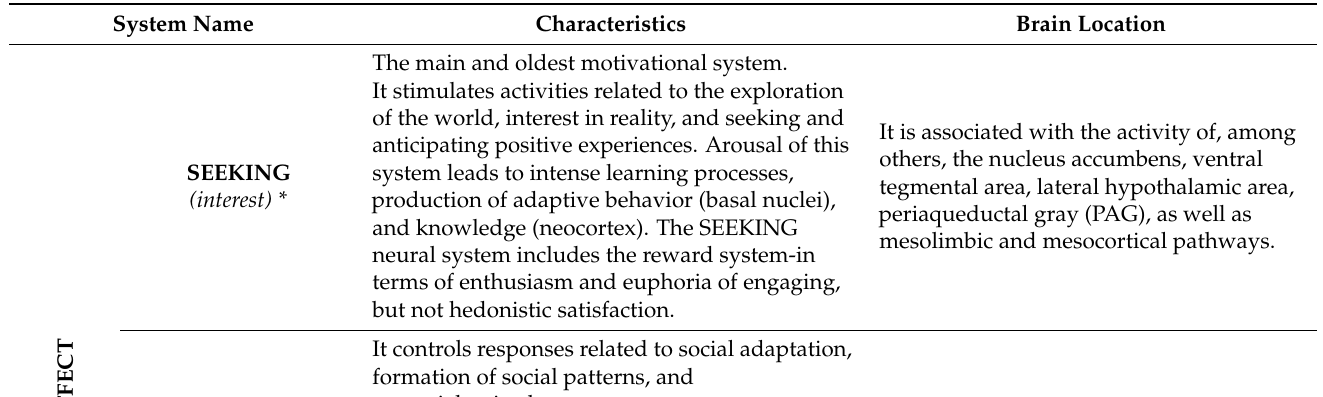
Table 1. Characteristics and biological basis of Panksepp’s neuroaffective emotional systems